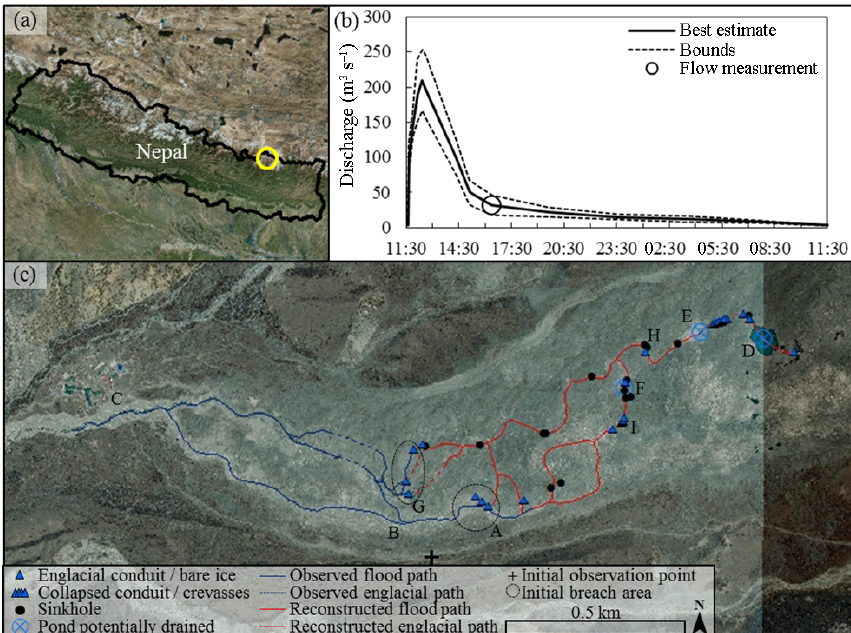
Figure 1. (a) Location of Lhotse Glacier in Nepal, (b) hydrograph of the glacier outburst flood from Lhotse Glacier on 12 June 2016, and (c) map of observations and the reconstructed flood path down to the village of Chukhung, with letters corresponding to key features in Fig.